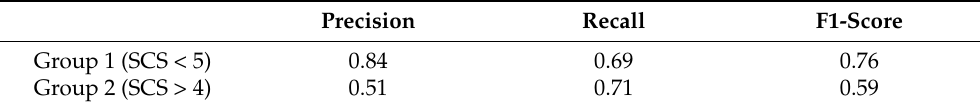
Table 3. DNN: precision, recall, and F1-score for both classes, namely Group 1 (SCS < 5) and Group 2 (SCS > 4).